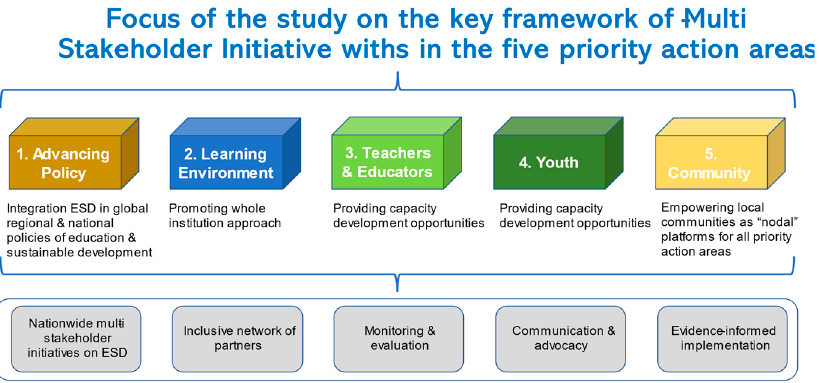
Figure 1. Five priority action areas of ESD (Authors edited and adopted from UNESCO: https://www.oneplanetnetwork.org/sites/default/files/esd_for_2030_one_pager_english.pdf) (Accessed on 12 March 2022).